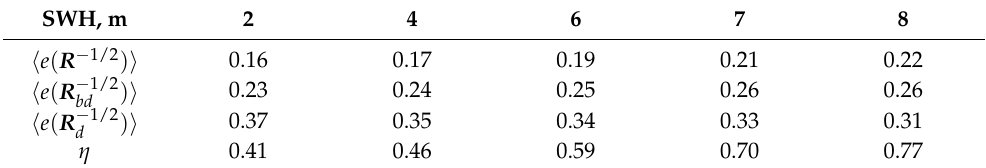
Table 2. Ensemble-averaged deviations e (Equation (16)) from the true SSH obtained in the assimila- tion experiments with the exact square root of the precision matrix in the definition of the normalized observation operator in Equation (1) (first line), with its block-diagonal R − 1/2 approximations shown in the middle. The contribution of the KaRIn noise to the total error covariance (in %) is displayed at the bottom